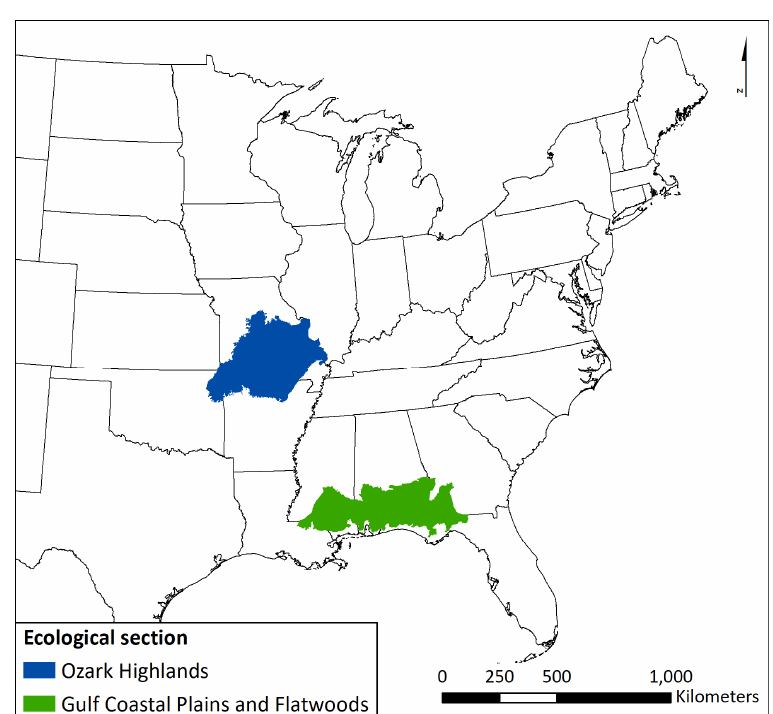
Figure 1. Two ecological sections containing forest inventory plots used for analysis, model parameterization, and validation.